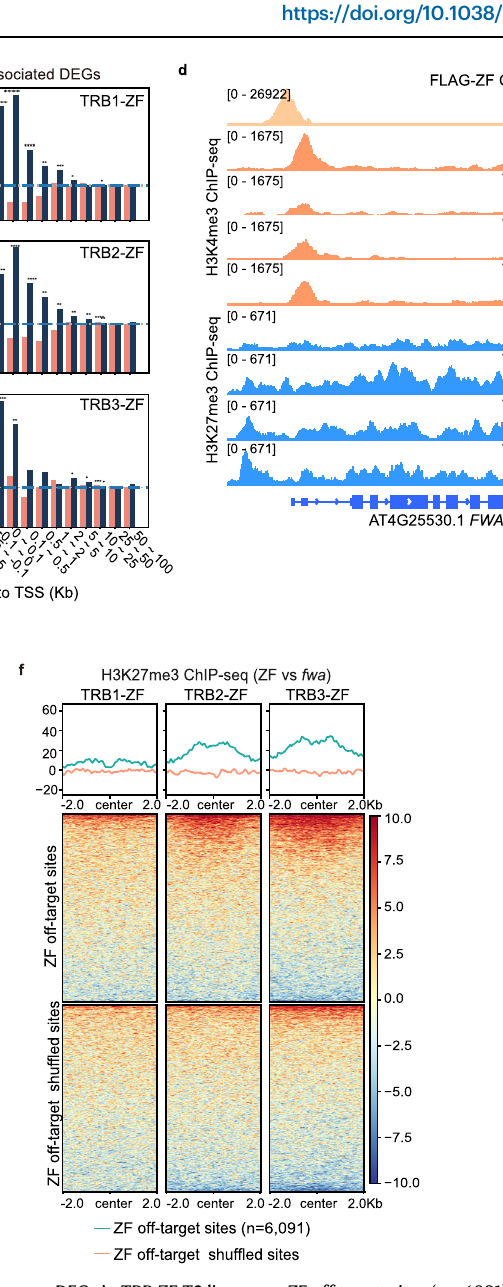
Col-0, and four representative T2 lines of TRB1-ZF, TRB2-ZF, and TRB3-ZF. b Bar chartshowing the relativemRNA levelof FWA in fwa and TRB1, TRB2,and TRB3T2 ZF fusion lines using normalized reads of RNA-seq data (RPKM). The error bars indicate the mean standard errors (SE) of the replicates ( n =3 biologically inde- pendent samples). c The observed/expected values of up- and